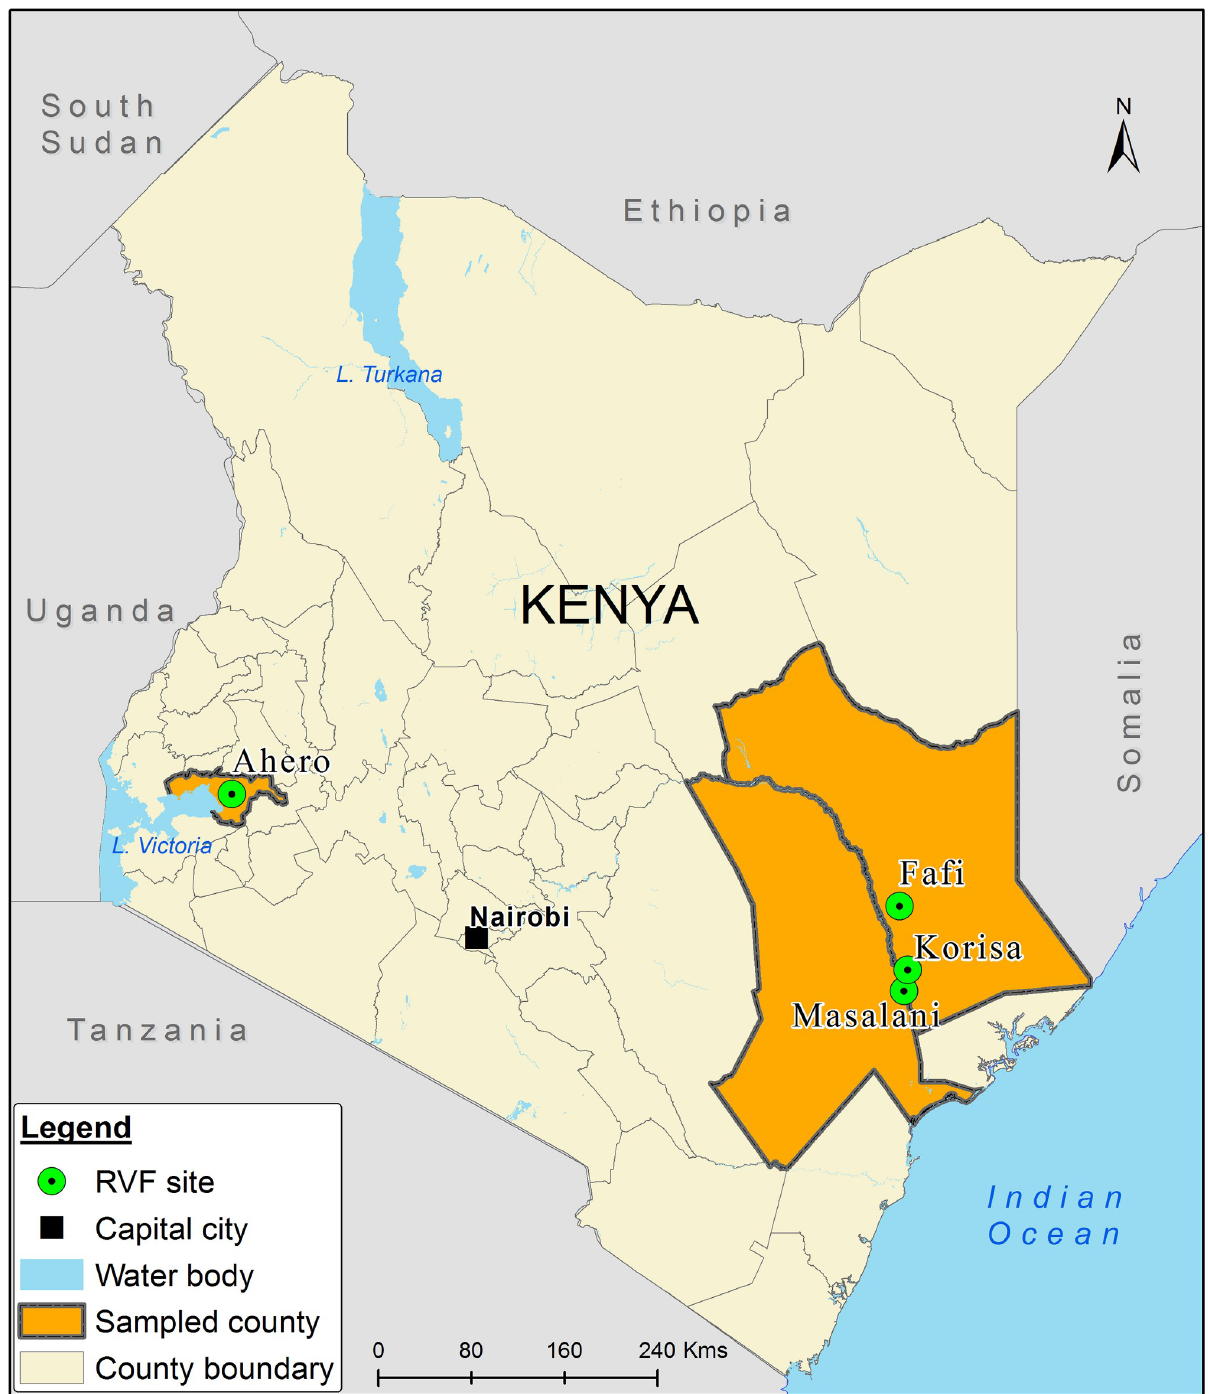
Fig 1. Map of Kenya showing mosquito sampling sites. The map was designed using ArcMap 10.2.2. with the ocean and lakes base layer derived from Natural Earth (http://www.naturalearthdata.com/, a free GIS data source). The sample points were collected using a GPS gadget (garmin etrex 20, https://buy.garmin.com/en-US/US/p/518046), and the county boundaries for Kenya derived from AfricaOpendata (https://africaopendata.org/dataset/ kenya-counties-shapefile, license Creative Commons).